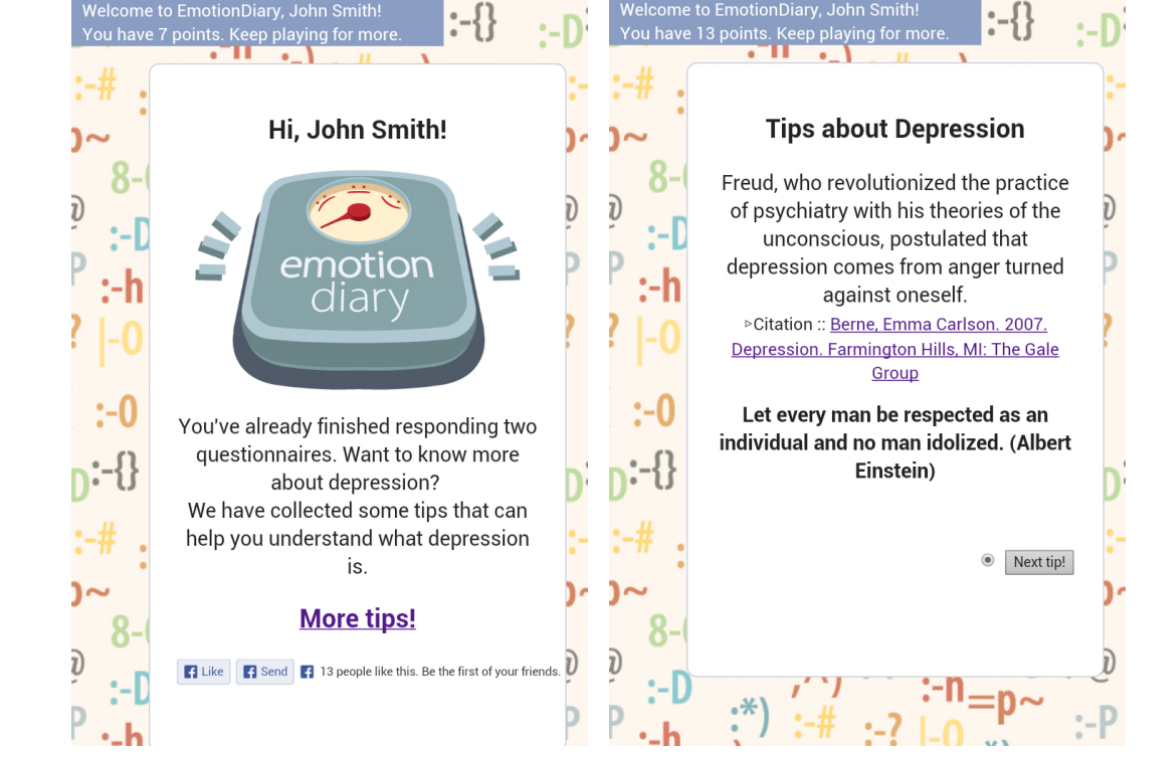
Figure 4. Flier for recruiting